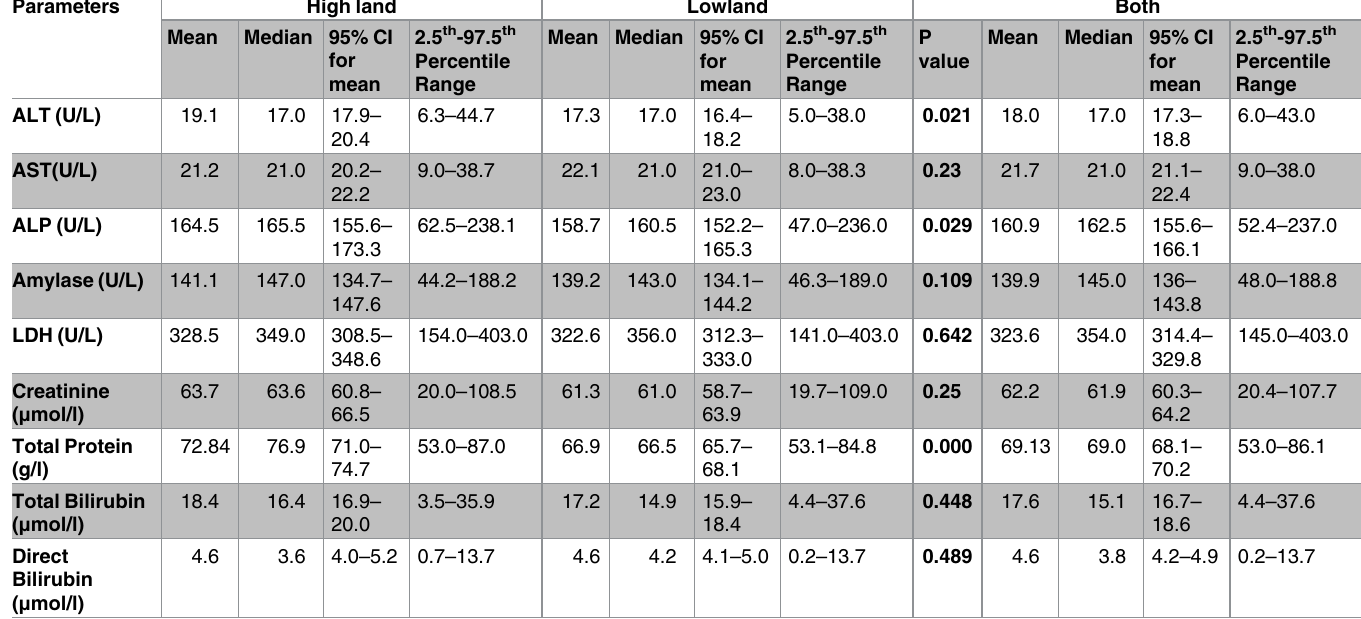
Table 6. Mean, median, 95% CI for mean and 2.5 th -97.5 th percentile of clinical chemistry referencevalues in relation to climate of healthy adults in Gojjam, Zones, Amahra National Regional State, Northwest Ethiopia.